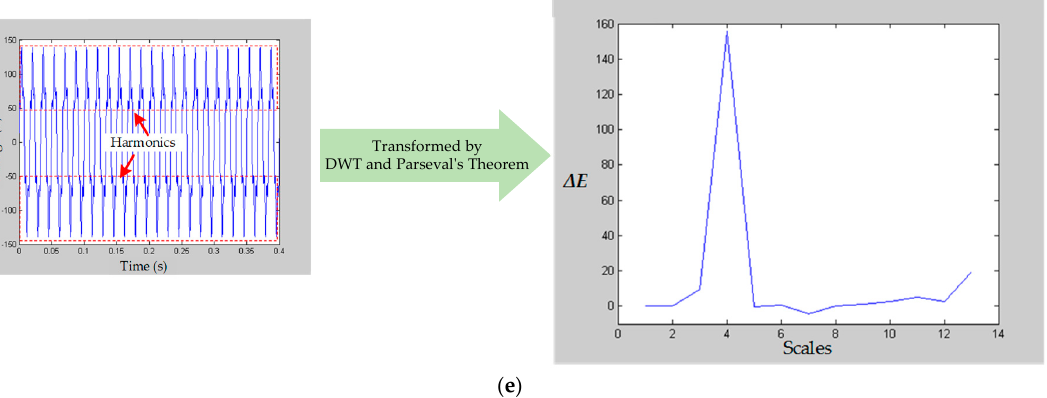
Figure 6. Energy feature curves with various disturbances: ( a ) power interruption energy feature curve; ( b ) voltage sag energy feature curve; ( c ) voltage swell energy feature curve; ( d ) voltage flicker energy feature curve; ( e ) power harmonics energy feature curve.